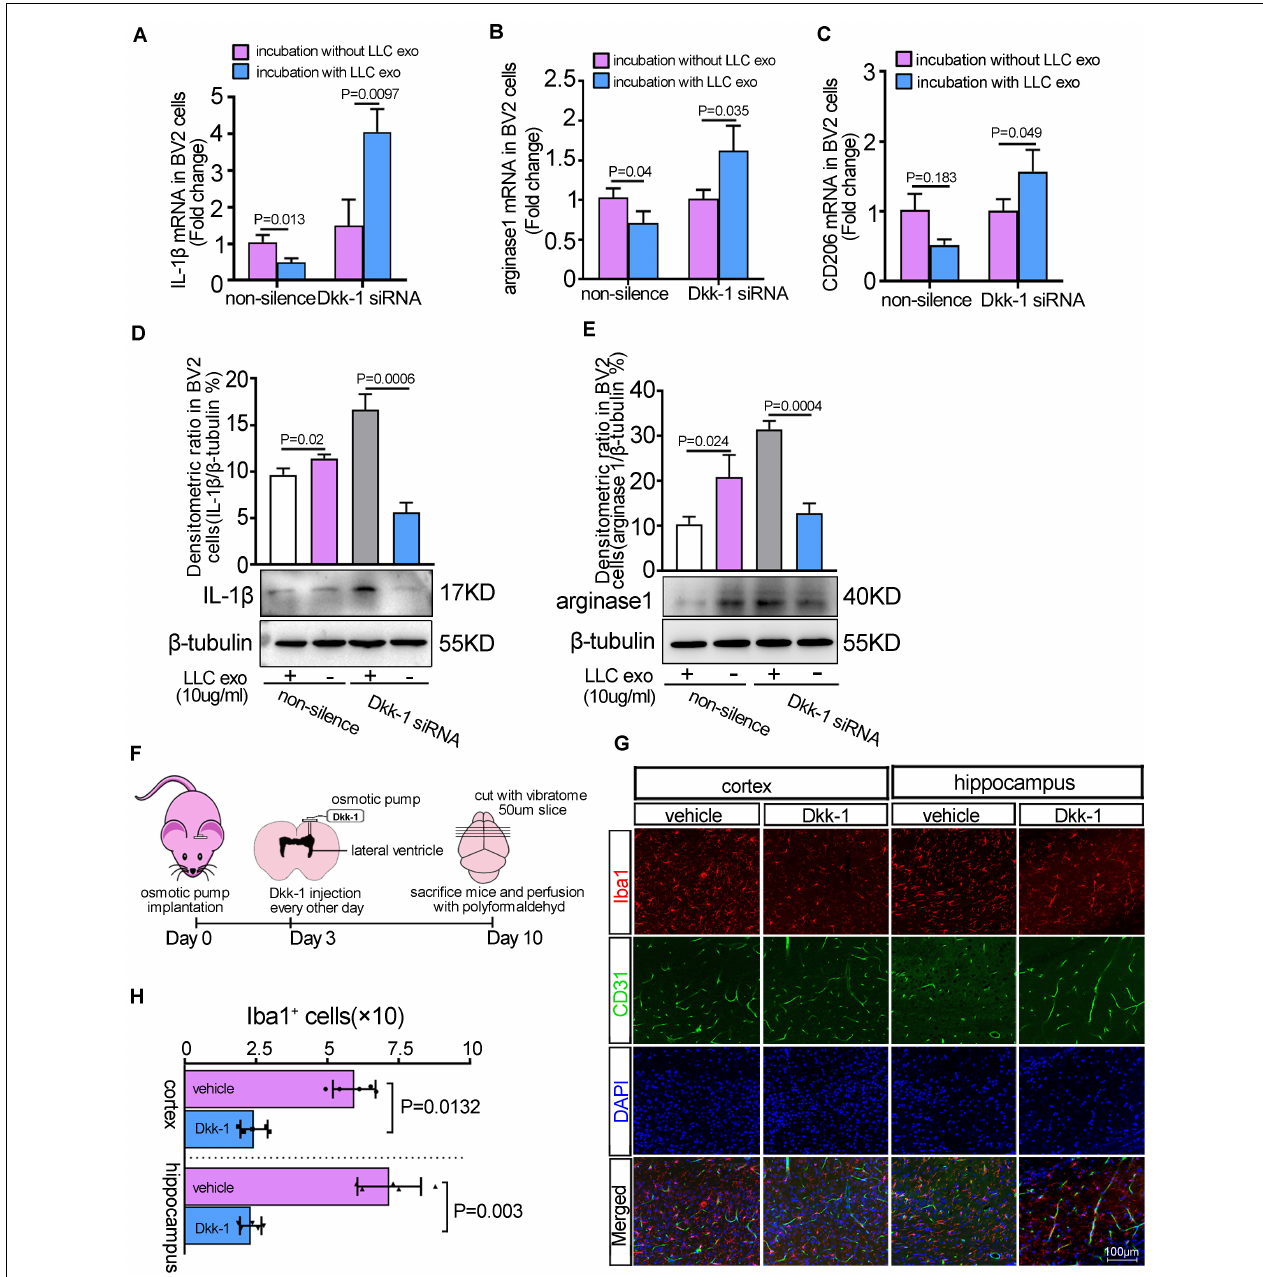
FIGURE 3 | LLC cells-derived exosomes-induced the release of Dkk-1 from the brain endothelium inhibited the phenotypic polarization of microglia. The brain endothelia cells (bEnd.3 cells) were transfected with Dkk-1 siRNA to knocked down the expression of Dkk-1, and co-cultured with BV2 cells in the presence or absence of LLC cells-derived exosomes. The qRT-PCR analyses for M1 marker, IL-1 β (A) and M2 Markers, arginase-1 (B), and CD206 (C) were shown. Results were presented as mean ± SD of three independent experiments. The quantitative analysis of western blots for M1 marker, IL-1 β (D) and M2 marker, arginase-1 (E) were shown. Above: The histogram represented the average levels of target proteins measured by densitometric values, normalized to the levels of β -tubulin. Results were presented as mean ± SD of three independent experiments. Below: The representative images of western blots for target proteins were shown. (F) Schematic illustration of the methods of Dkk-1 administration to mice. (G) The immunofluorescence staining for Iba1 and CD31 in the injected sides of cerebral cortex and hippocampus after intra-ventricular injection of Dkk-1. Scale bar, 100 µ m. (H) The quantitative analysis for the numbers of Iba-1-positive microglia cells. The PBS alone was as the vehicle. The histograms represented the average numbers of Iba-1-positive microglia cells from the total 6 random visual fields in three independent experiments.